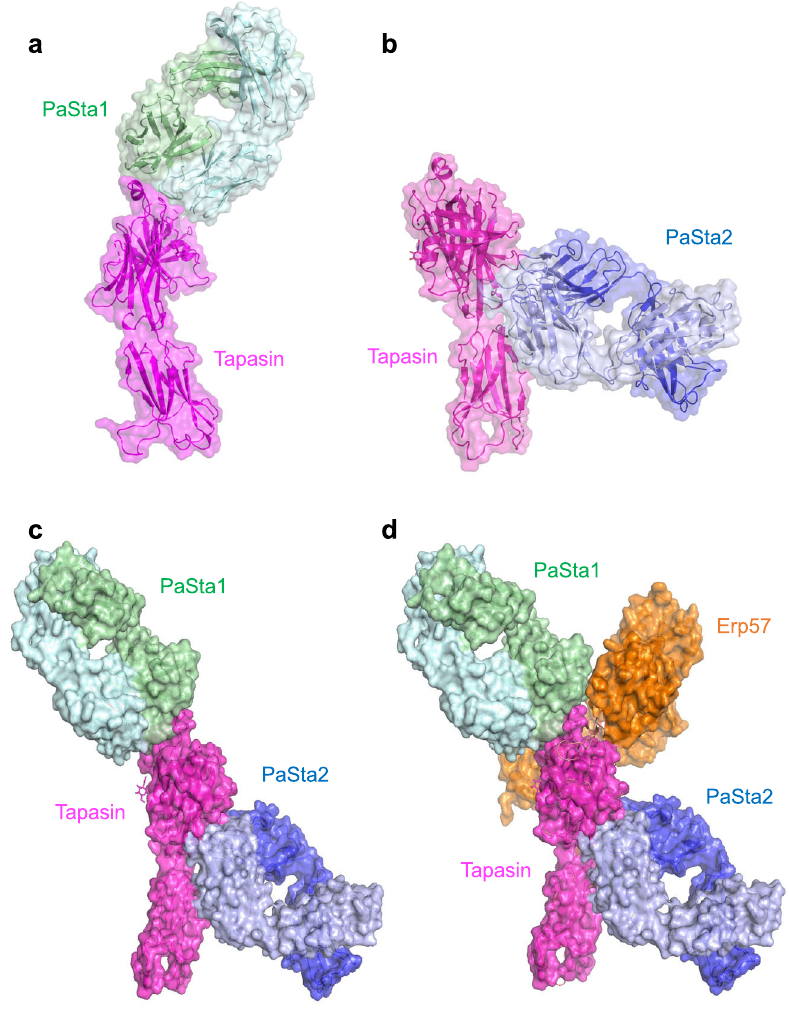
Fig. 4 | Structures of tapasin – PaSta1 (7TUF) and tapasin – PaSta2 (7TUG) com- plexes locate sites of antibody interactions. a Ribbon/transparent surface representation of the structures of the tapasin – PaSta1 complex. b tapasin – PaSta2